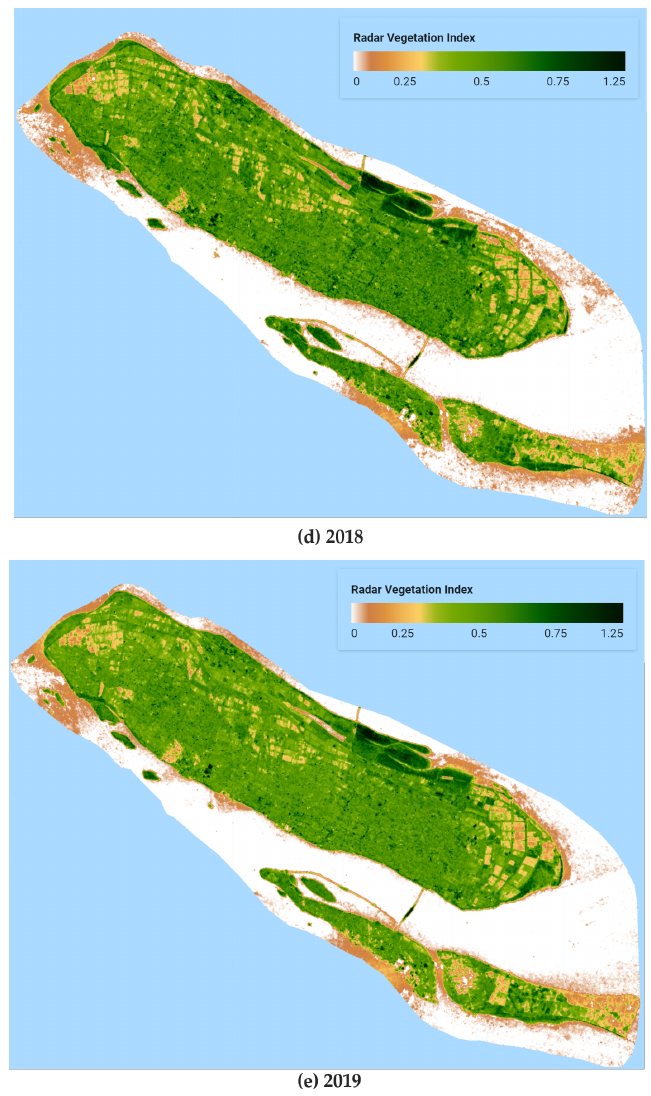
Figure 8. This figure shows radar vegetation index retrieved by Sentinel-1 SAR data for indicating the forest growth level of Chongming island from 2015 to